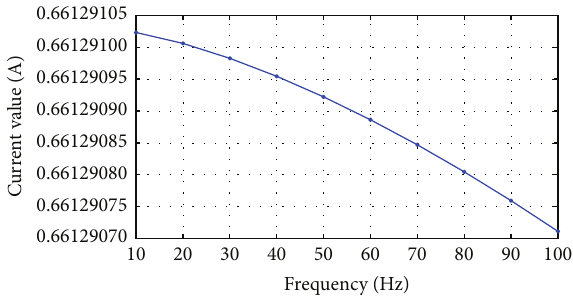
Figure 7: Curve of the maximum current value with the frequency.